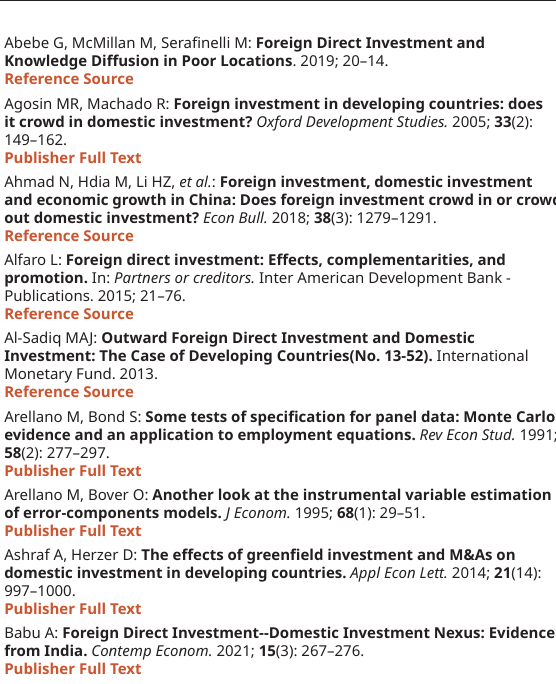
Figshare: Foreign Direct Investment crowding out Domestic Investment in Food Manufacturing, https://doi.org/10.6084/m9. figshare.13591235.v2 (Djokoto,